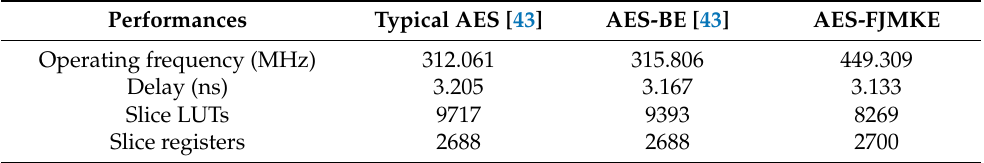
Table 10. Comparison of AES-FJMKE and AES-BE for Virtex 6.